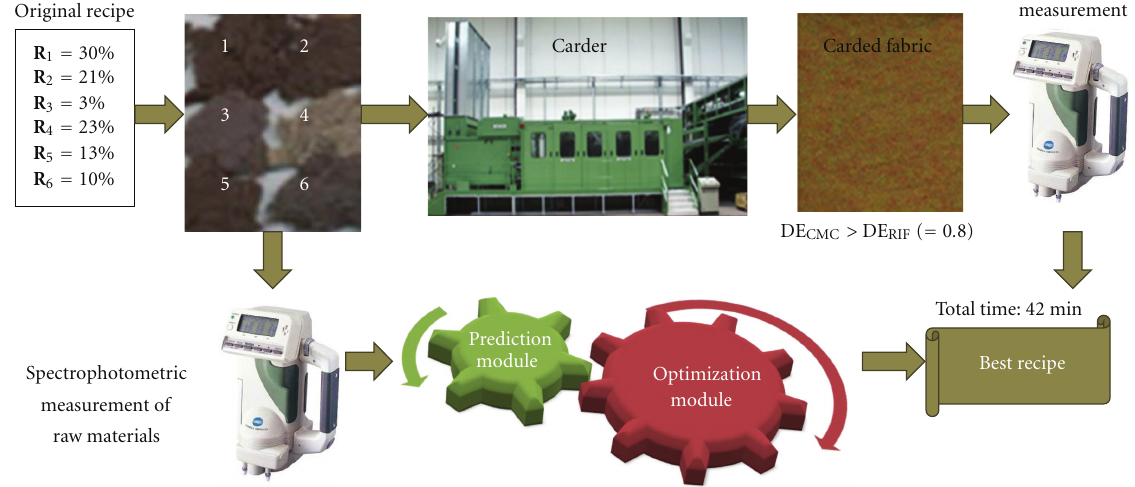
Figure 2: New process for optimizing the recipe. The devised model is composed by two modules: prediction and optimization.